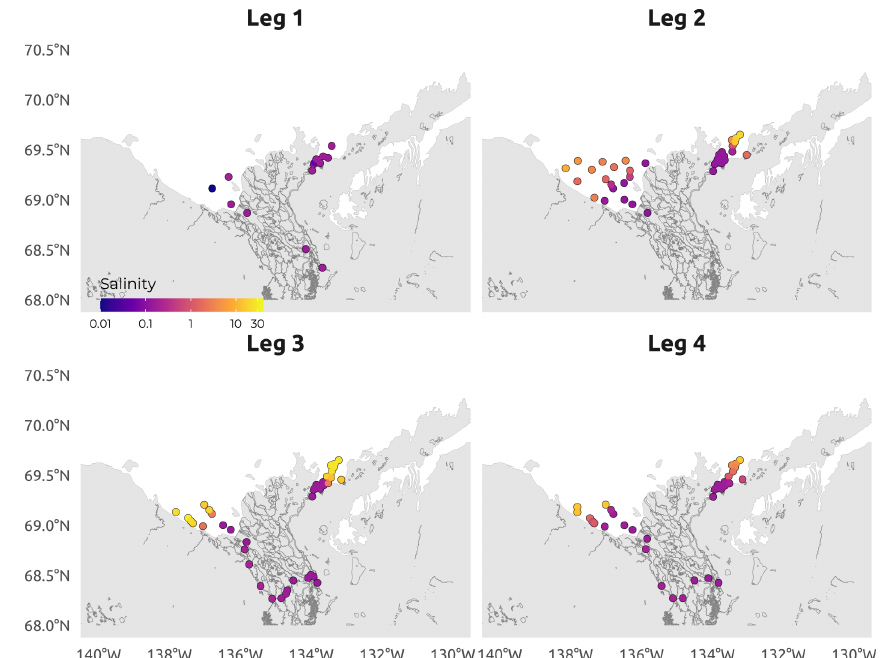
Figure 5. Spatial distribution of the CTD-measured surface salinity (conductivity) during the four WP4 Nunataryuk expeditions (Legs 1, 2, 3, and 4) in 2019. Note the log10 color scale used to visualize the salinity gradient. Surface here refers to samples collected between 0.30 and